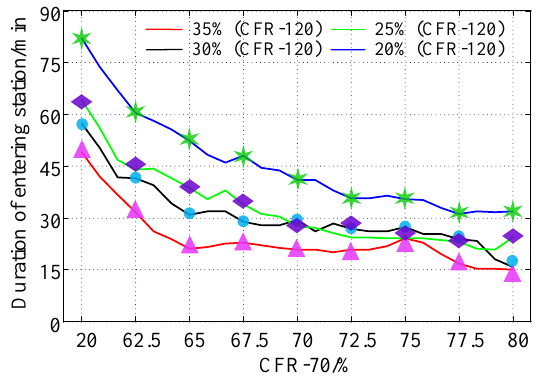
Figure 20. Duration of entering station under different groups of CFR.